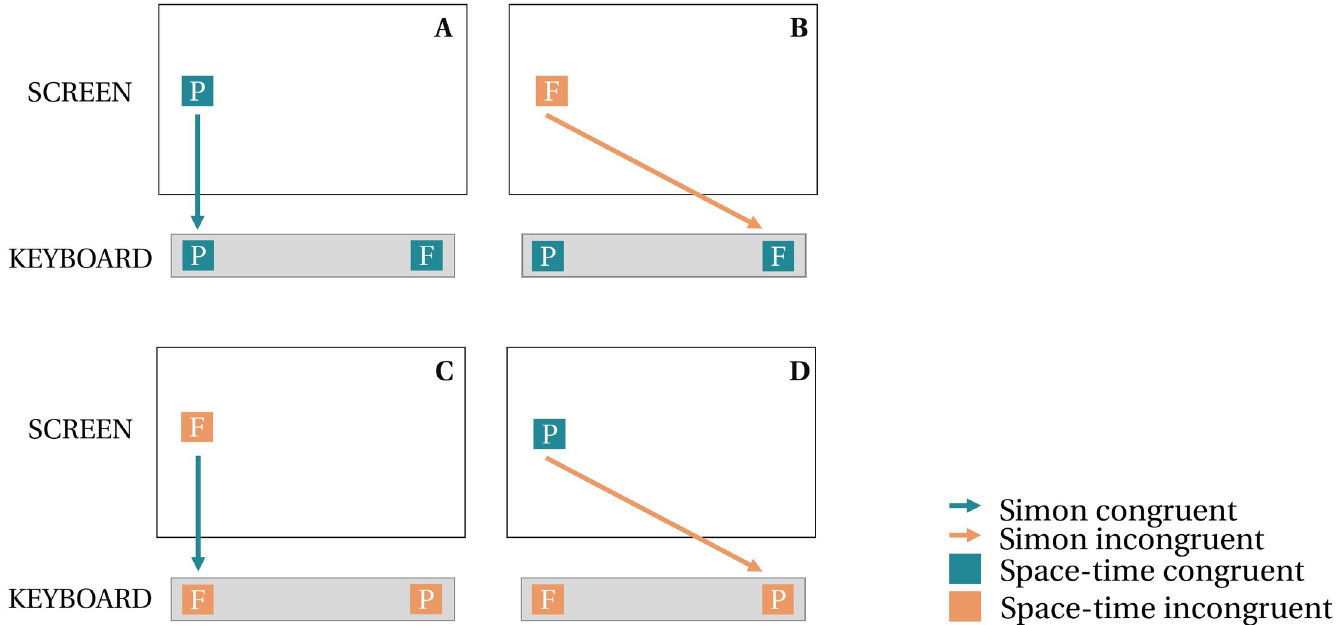
Fig 2. Congruency conditions. The figure illustrates the four congruency conditions for left-sided stimuli but note that four analogous conditions were also presented for right-sided stimuli. A and B correspond to keyboard congruent conditions, C and D correspond to keyboard incongruent conditions. In an orthogonal manner, A and D correspond to screen congruent conditions, B and C correspond to screen incongruent conditions. Finally, due to the orthogonalization of keyboard and screen location, A and C correspond to Simon congruent conditions and B and D correspond to Simon incongruent conditions. Note that Simon congruency was not manipulated orthogonally with space-time congruency effects but instead was simply a potential confound in the experimental design that we wished to control for, by including it as a predictor in the statistical analysis. P: past-tense stimulus. F: future-tense stimulus.